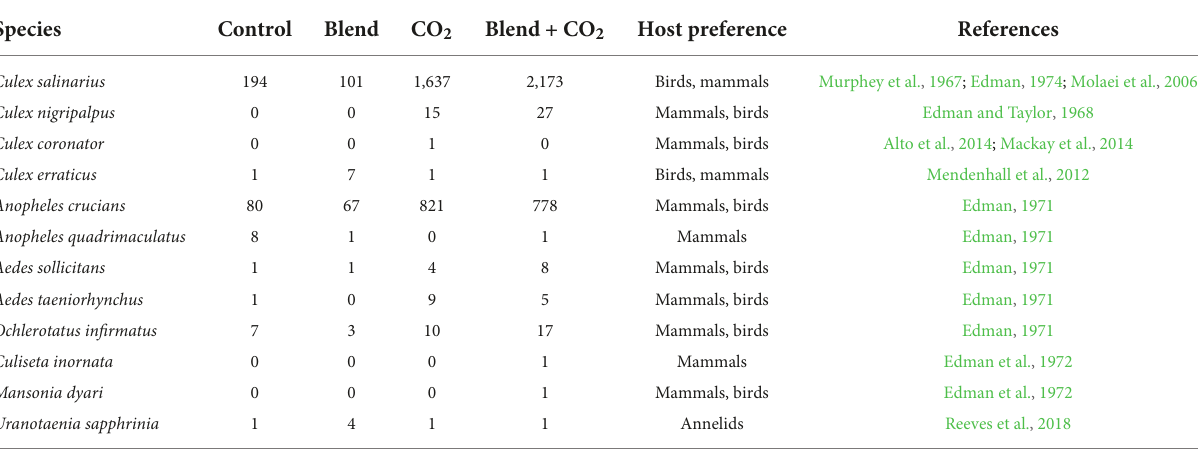
TABLE 2 Species and number of mosquitoes caught at Cedar Key Scrub State Reserve (FL, United States) using odor-baited Center of Disease Control mosquito traps.